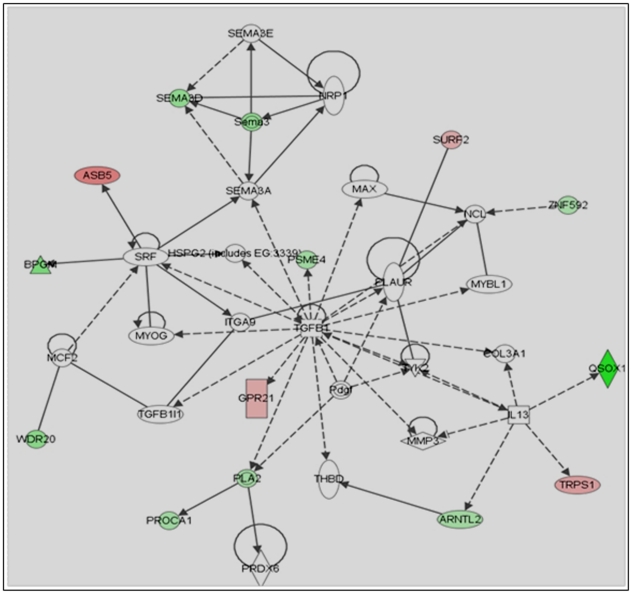
Ingenuity Pathway Analysis (IPA) of cell cycle related genes in p85α−/− MCp's in response to SCF stimulation.Altered genes in p85α−/− cells after SCF stimulation were analyzed by IPA software to analyze their closely associated gene network. Significantly altered cell cycle related genes in p85α−/− MCp's in response to SCF stimulation were indicated.